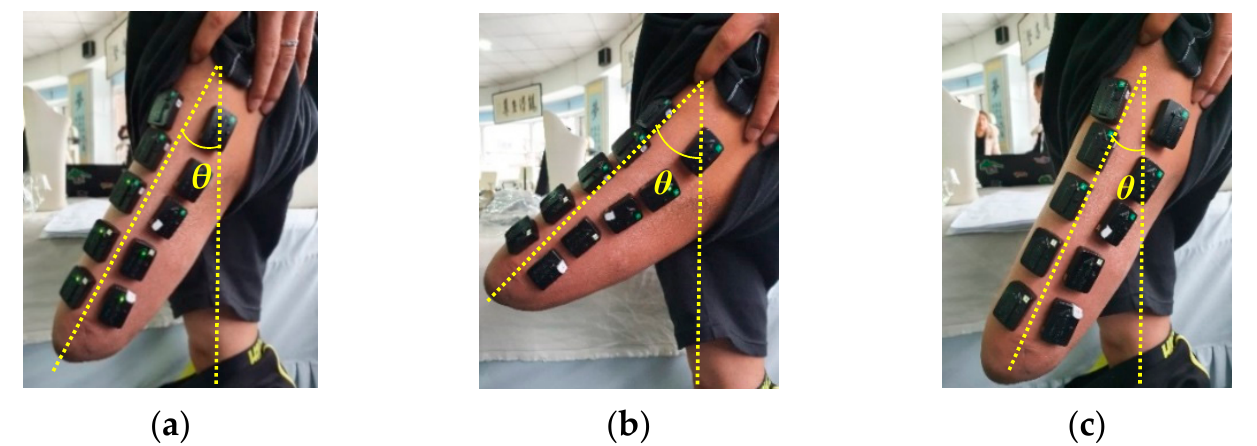
Figure 3. The three movement conditions. ( a ) appropriate angle, θ = 35°, ( b ) excessive angle, θ = 45°, ( c ) angle too small, θ = 25°.